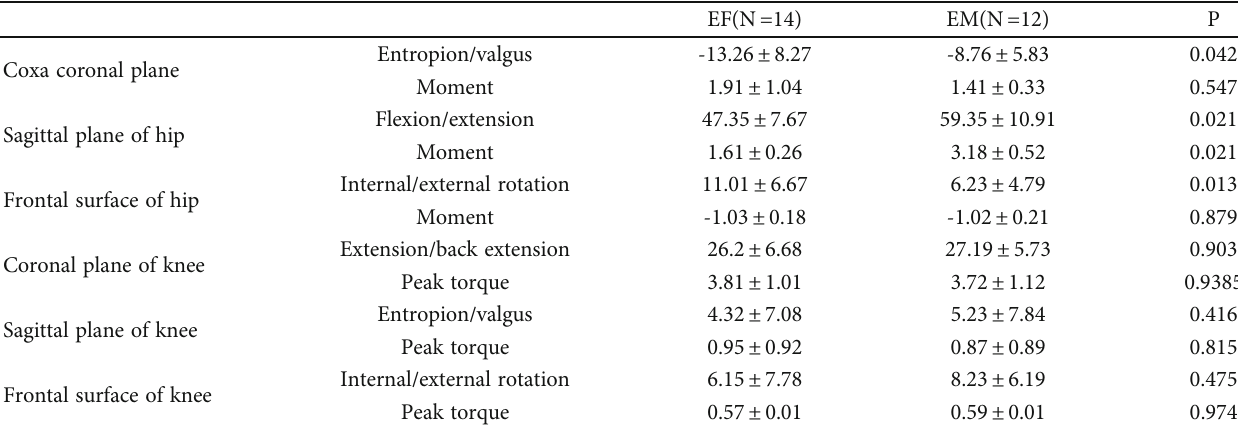
Table 2: Peak value comparison of dynamic parameters of joints of elite male and female soccer players (M ± SD).